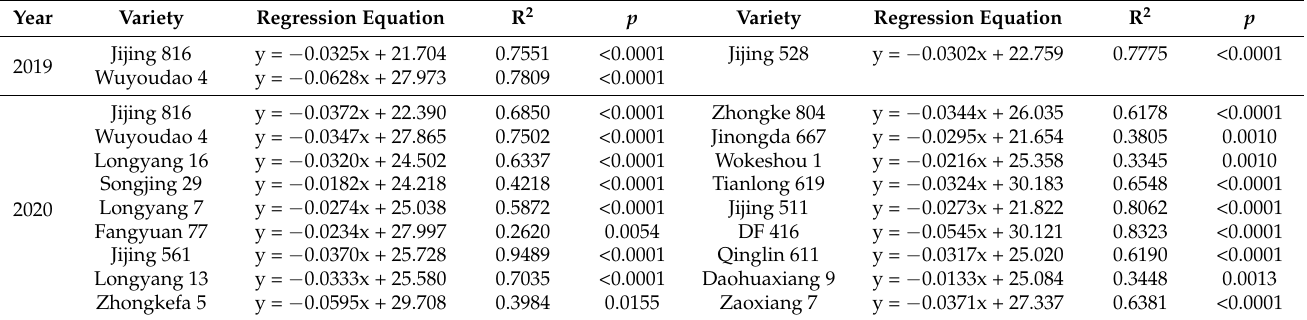
Table 1. Standard-moisture 1000-grain weight models based on a standard 15% moisture content